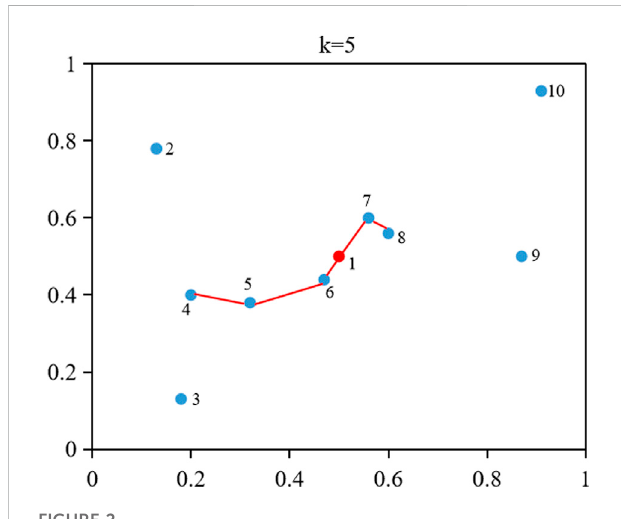
FIGURE 2 An example of calculating the SPS, SPRS, and SPCS of object